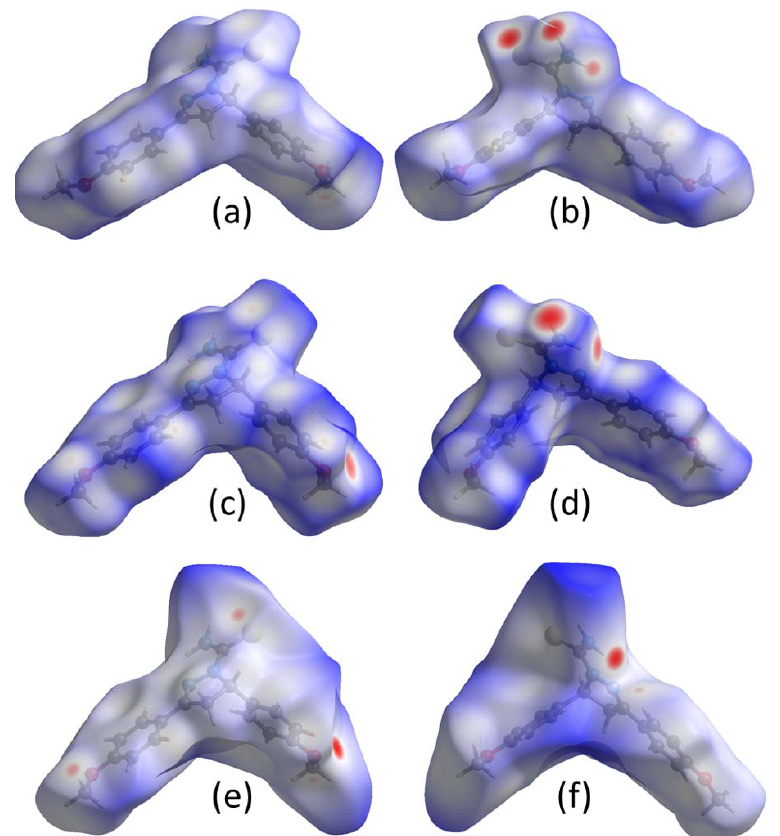
Figure 5. Hirshfeld surfaces for molecule 1 in the crystal structures of ( a , b ): cocrystal 1–2 , ( c , d ): 1 – DMF solvate, and ( e , f ): pure 1 .